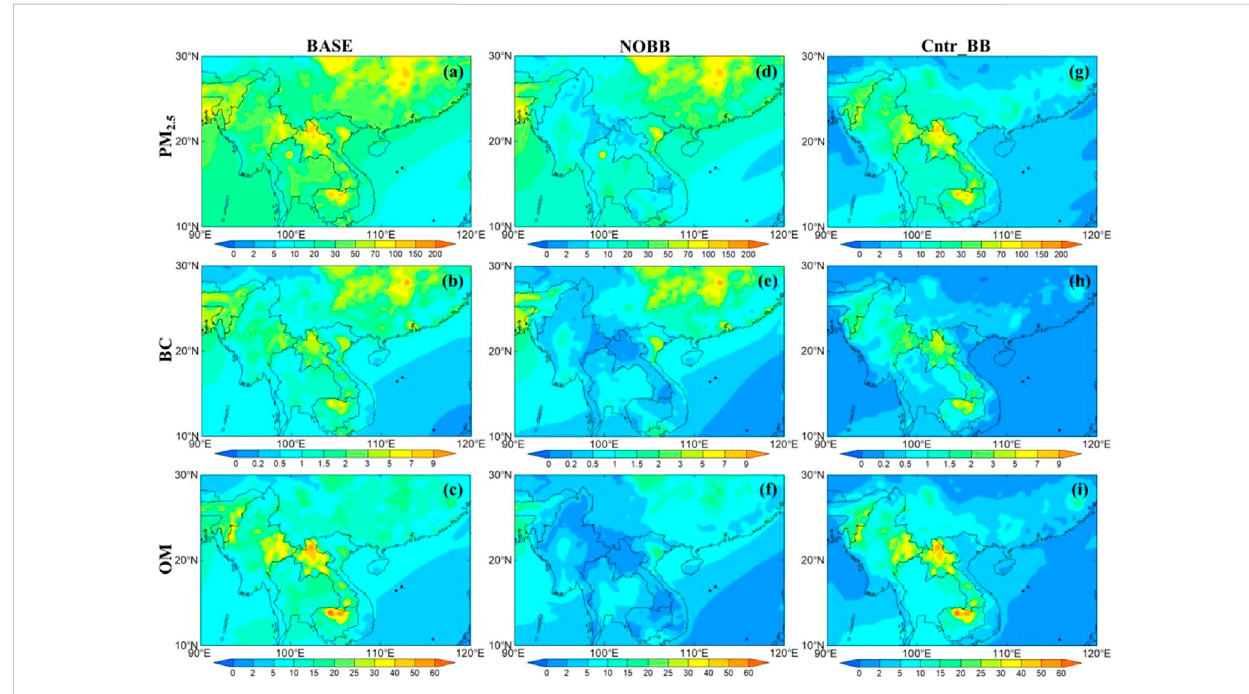
FIGURE 3 Modeled period mean near-surface concentrations (units: μ g/m 3 ) of (A, D, G) PM 2.5 , (B, E, H) BC, and (C, F, I) OM from (A – C) all emissions (BASE), (D – F) emissions other than biomass burning (NOBB), and (G – I) biomass burning